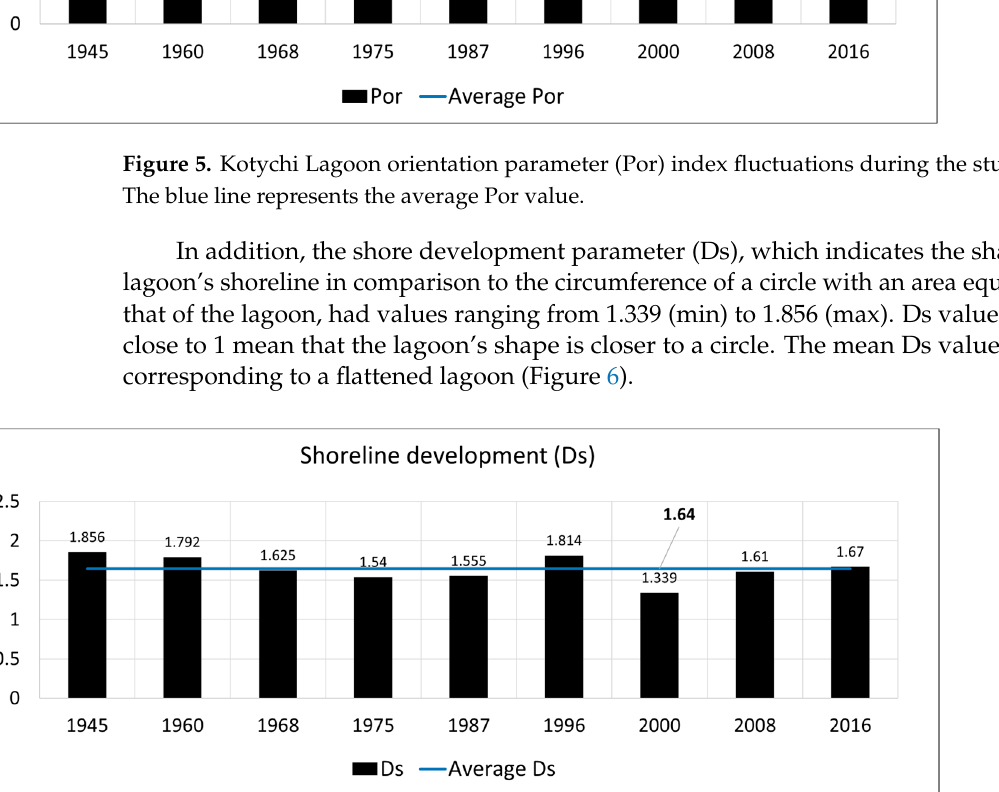
Figure 5. Kotychi Lagoon orientation parameter (Por) index fluctuations during the study period. The blue line represents the average Por value.